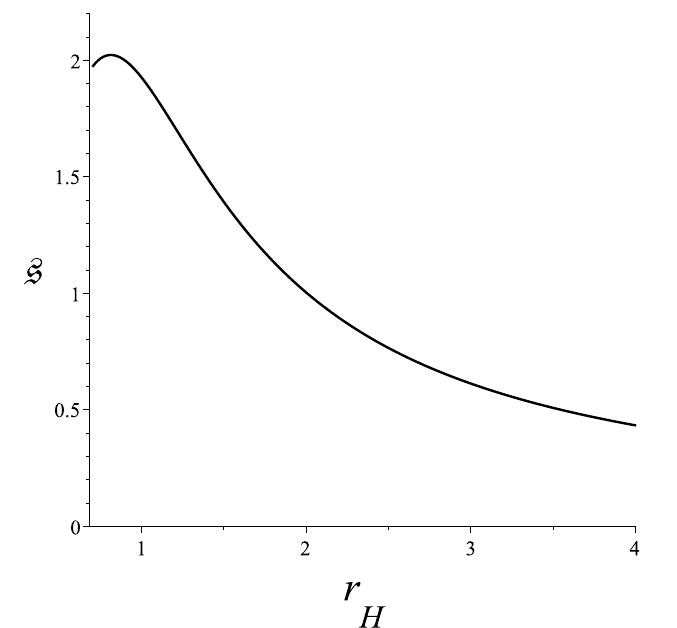
JHEP02(2023)072 Figure 4 . Specific entropy of a “large” AdS 5 -Reissner-Nordström black hole with temperature equal to the minimal possible temperature of an AdS 5 -Schwarzschild black hole, using units in which L = 1. Here r H is a proxy for the charge, with which it varies as a monotonically increasing function when the temperature is fixed. The physical domain is to the right of r H 0 . 707 , which ≈ is slightly smaller than at the maximum, r H 0 . ≈